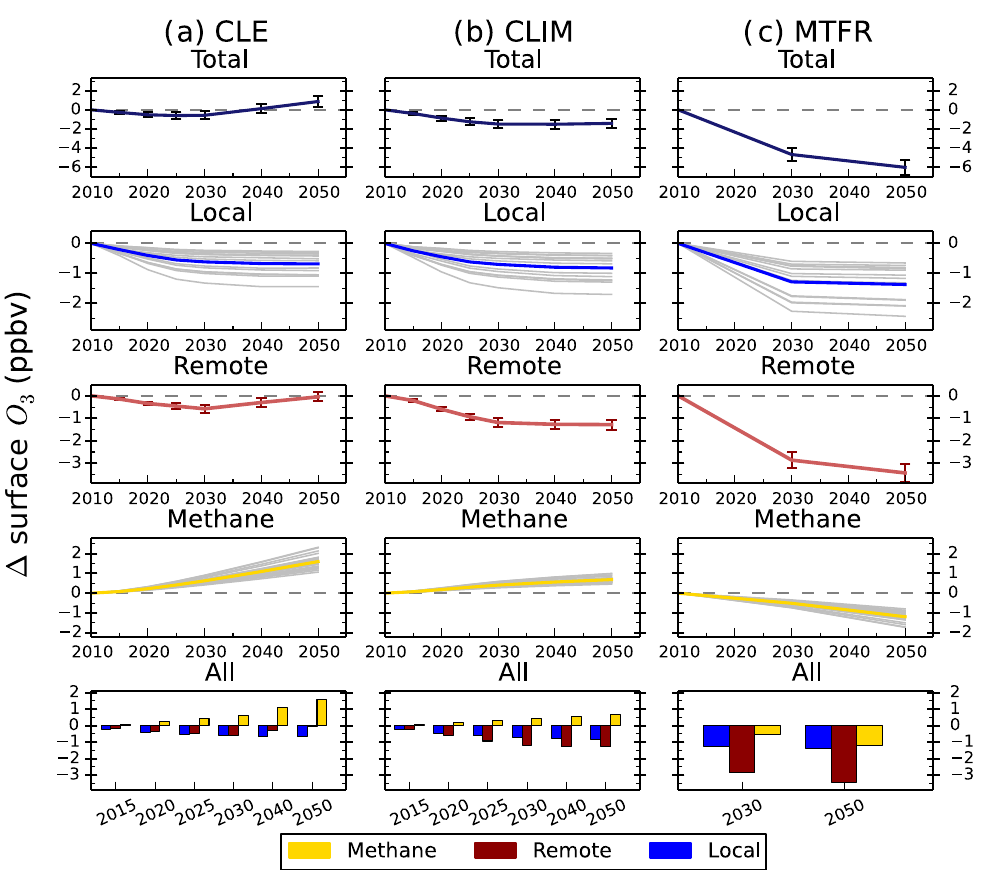
Figure 7. Total annual mean change in regional surface O 3 concentrations over Europe and the contribution of local (blue), remote (red) and methane (gold) sources between 2010 and 2050 from the parameterisation for the ECLIPSE V5a emissions under the CLE (a) , CLIM (b) and MTFR (c) scenarios. Grey lines on the local and methane panels represent individual model estimates of O 3 changes, showing the spread in model responses; solid lines show the multi-model mean. Error bars represent 1 standard deviation over the model range. The last row of panels shows the O 3 response from individual sources plotted together for each year.